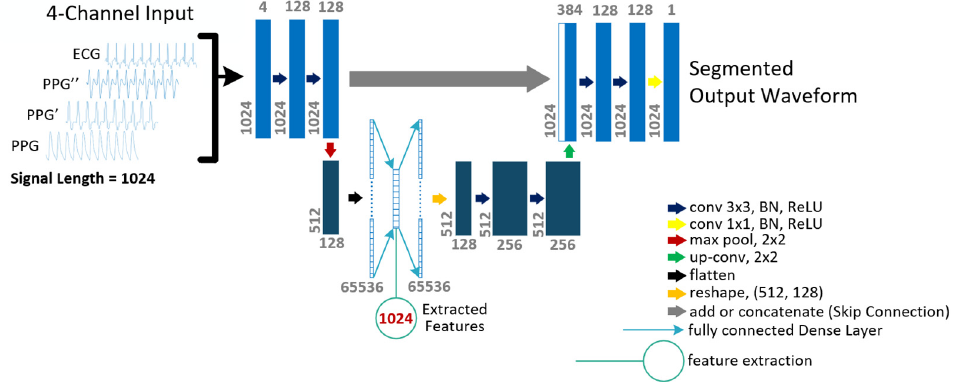
Figure 6. Architecture of the shallow U-Net model for feature extraction.